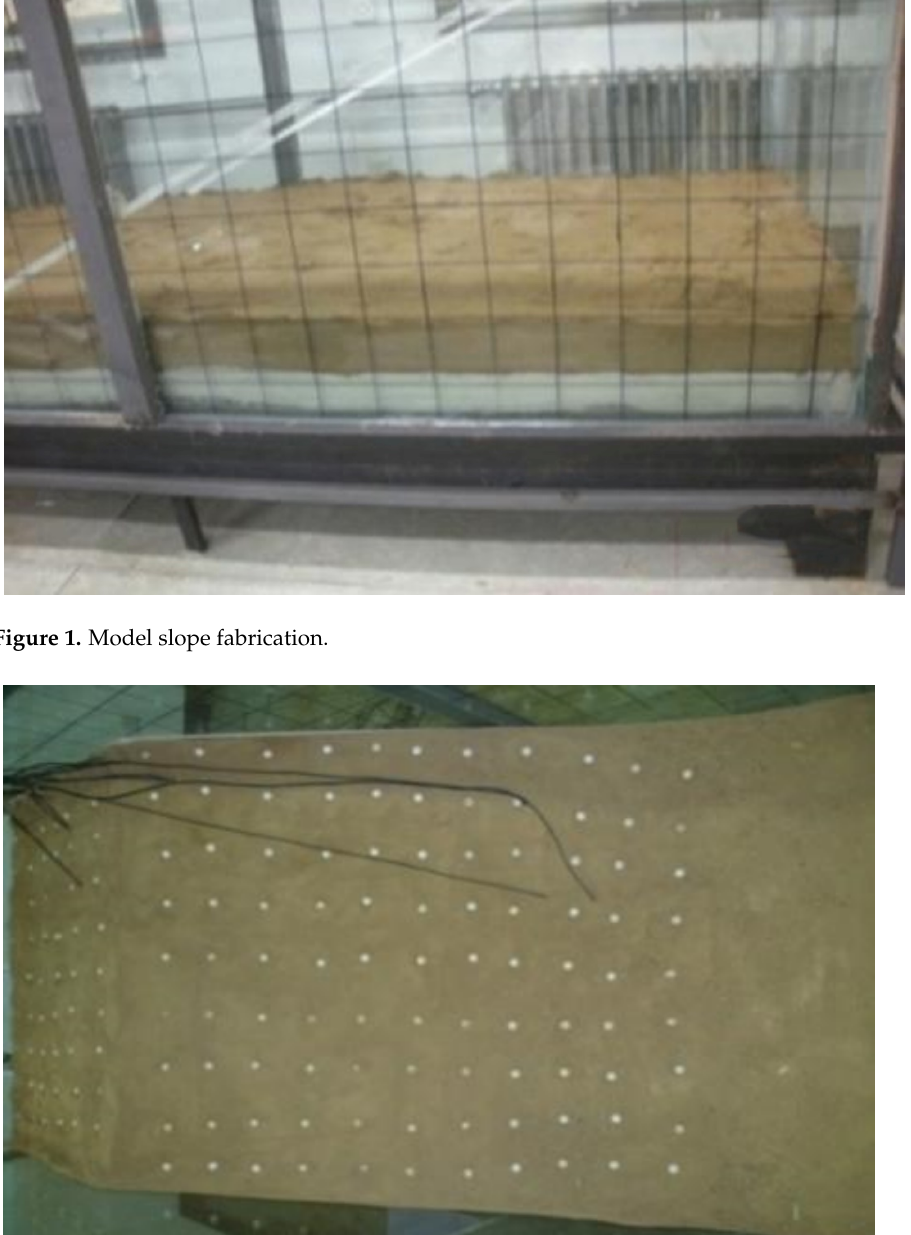
Figure 2. Slope sign layout.